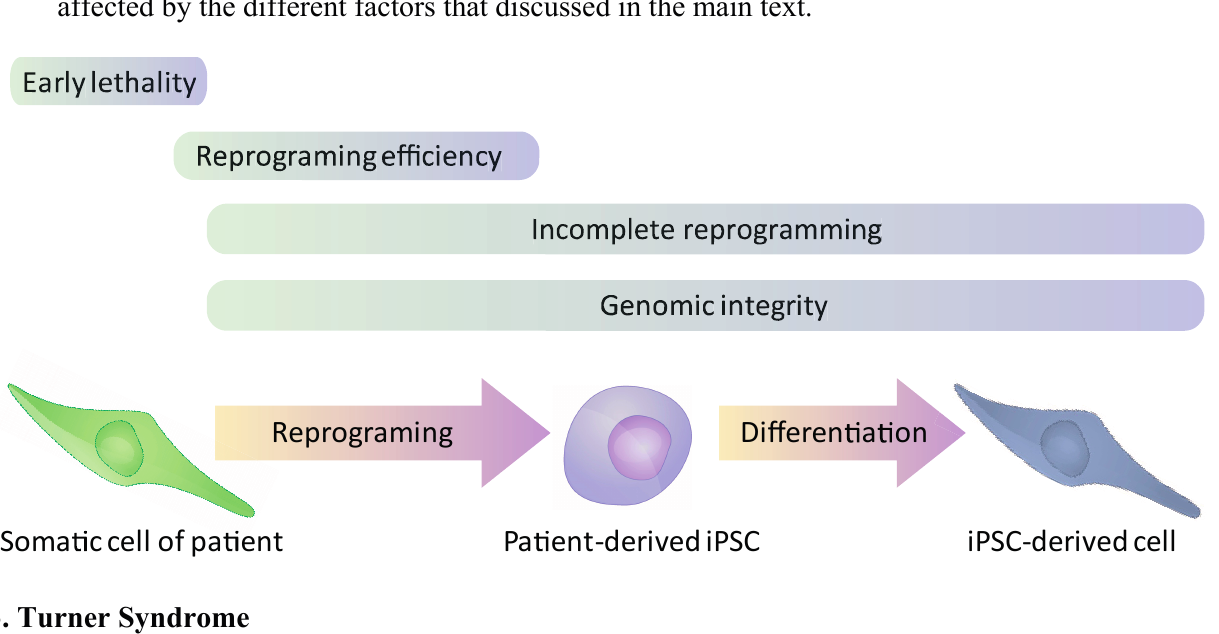
Figure 2. Limitations in the generation of iPSC-based disease models. The “X-axis” in this scheme depicts the specific stages during the formation of iPSC-based models that might be affected by the different factors that discussed in the main